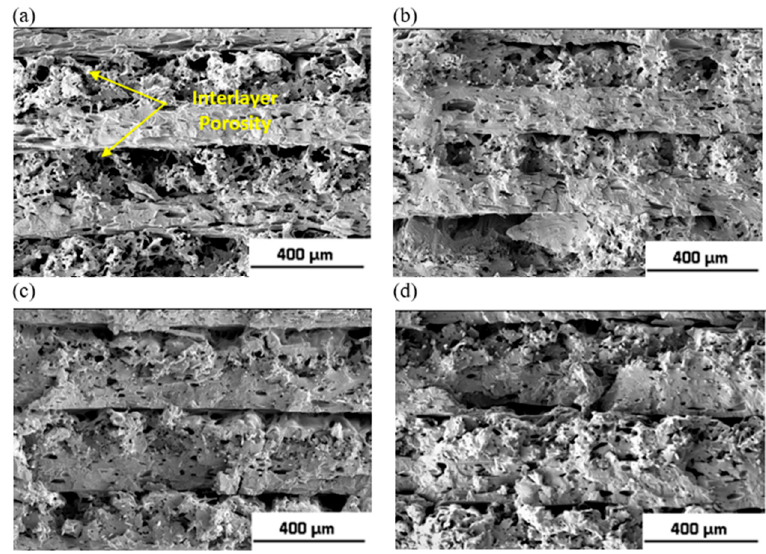
Figure 4. Mesostructure of CF-PA composites printed at ( a ) 230 °C, ( b ) 250 °C, ( c ) 270 °C, ( d ) 290 °C [100 × ].